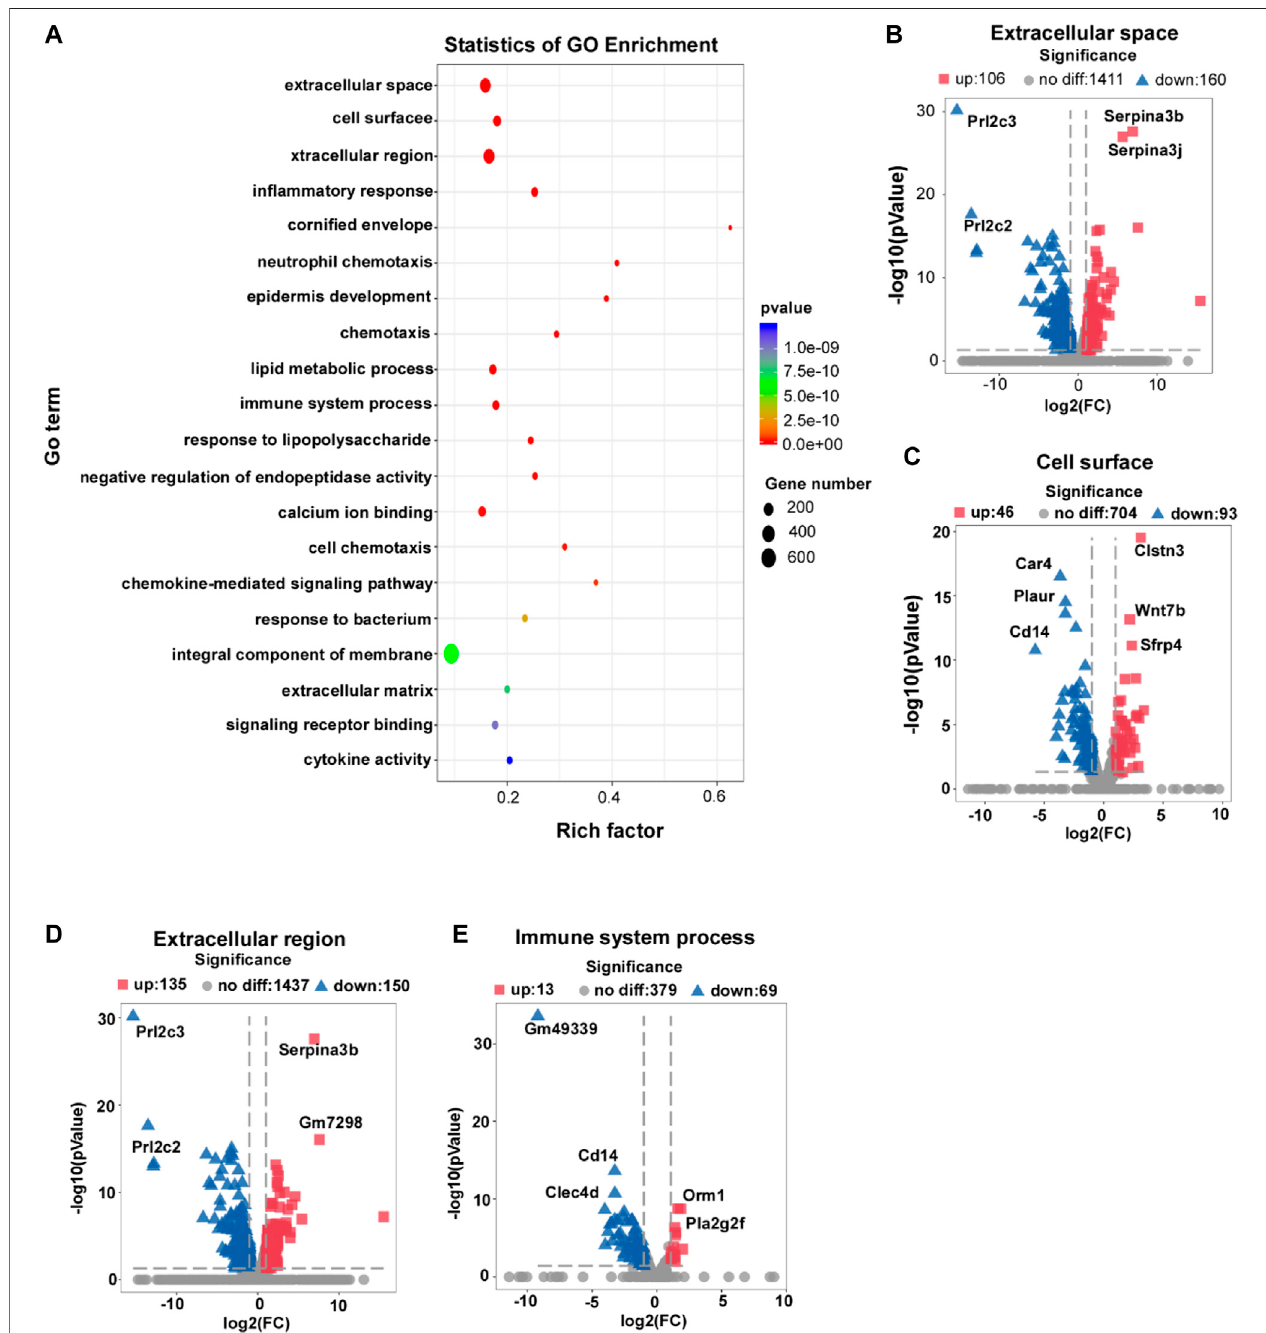
FIGURE4| L-THEregulatesthegeneexpressionpro fi lesofextracellularspace,cellsurfaceandextracellularregion. (A) ScatterplotforGOanalysisbasedonRNA- seq data from IMQ-induced psoriasis mice treated with 100 mM L-THE or H2O for 5 days. (B – E) Volcano plot showed the expression of extracellular space (B) , cell surface (C) , extracellular region (D) , and immune system process. (E) associated genes.